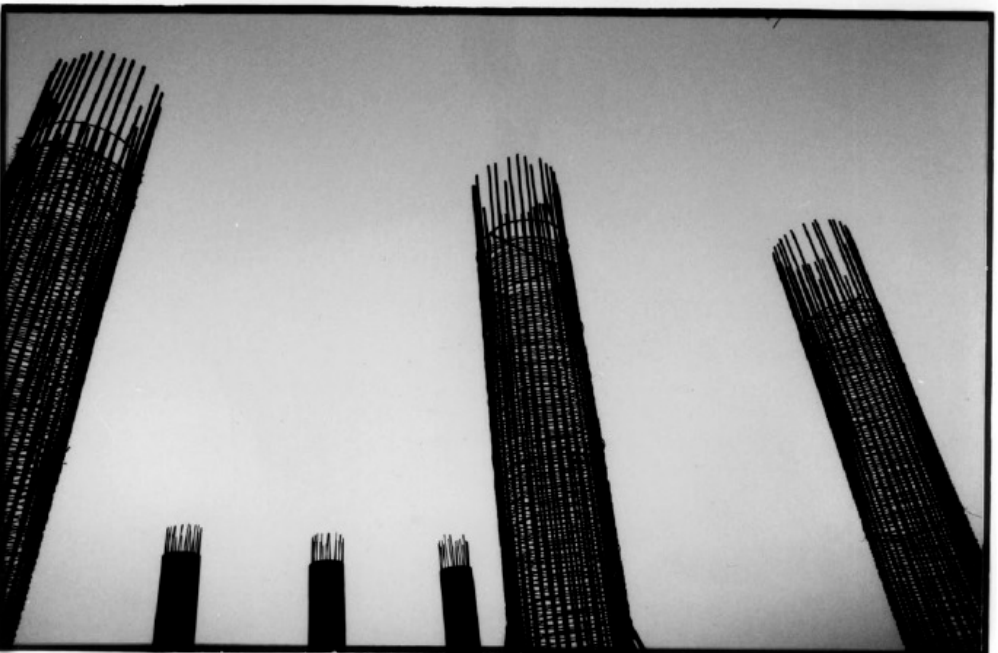
Figure 9. Mohammad Ghazali, from the Persepolis 2560–2580 series, Lost no. 017, 2001–2021, Analog photography, gelatine silver print, 13.5 × 20.5 cm.